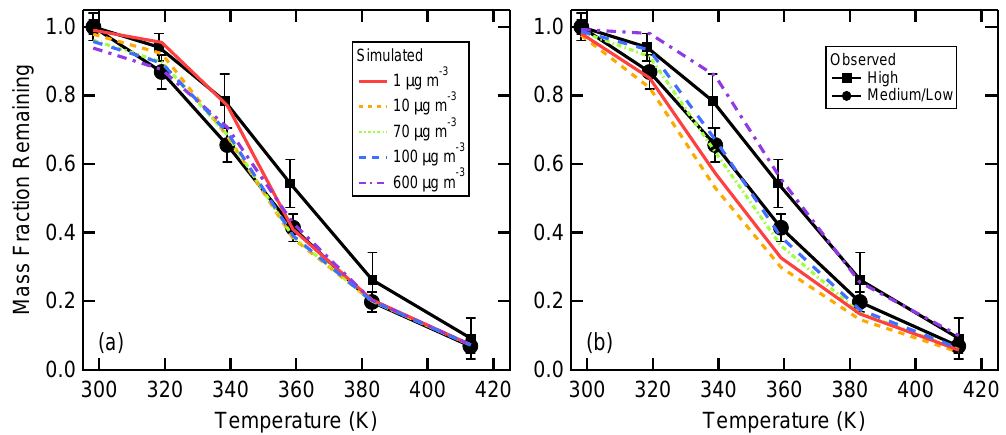
Figure 5. (a) Calculated mass thermograms for variable C OA based on the best-fit parameters for the K eqm = 10 − 16 cm 3 molecule − 1 dimer- decomposition model as compared to the observations for the average medium/low and high C OA . (b) Same as (a) but for the best-fit low-volatility